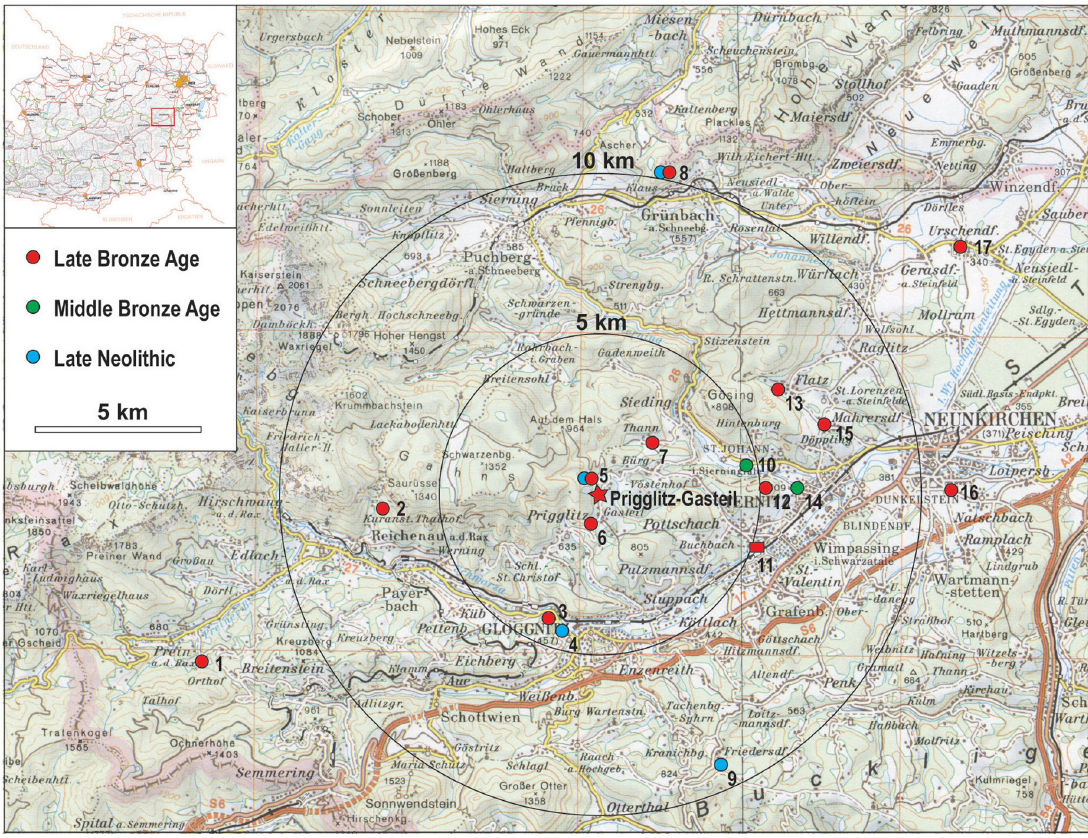
Fig 1. Location of Prigglitz-Gasteil and the surrounding sample findspots. Cartography from the Bundesamt fu¨r Eich- und Vermessungswesen (BEV) with kind permission from BEV, original copyright [2021]. 1 Prein an der Rax; 2 Reichenau- Kammerwandgrotte; 3 Heufeld-Heukogel; 4 Gloggnitz (Semmeringtunnelportal); 5 Prigglitz-Gasteil/Bu¨rg (Klausgraben); 6 Prigglitz- Gasteil (Kapelle); 7 Sieding (Murrer); 8 Gru¨nbach am Schneeberg-Gela¨nde; 9 Kranichberg-Karlho¨he; 10 Sieding; 11 Pottschach; 12 Ternitz-Gfieder; 13 Flatz-Go¨sing; 14 Ternitz-St. Johann; 15 Mahrersdorf; 16 Neunkirchen/Natschbach-Klostera¨cker; 17